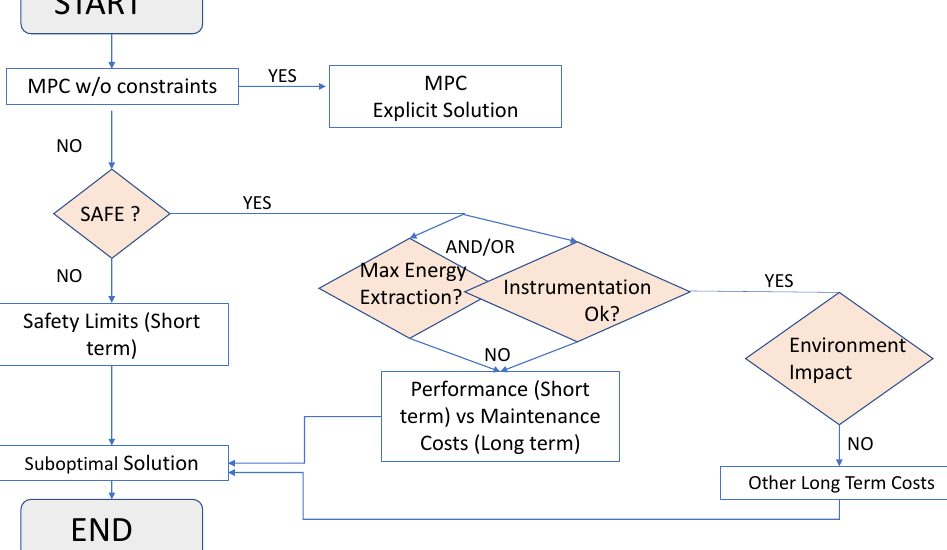
Figure 4. Flowchart of the sequential prioritized optimization scheme. Model based predictive control